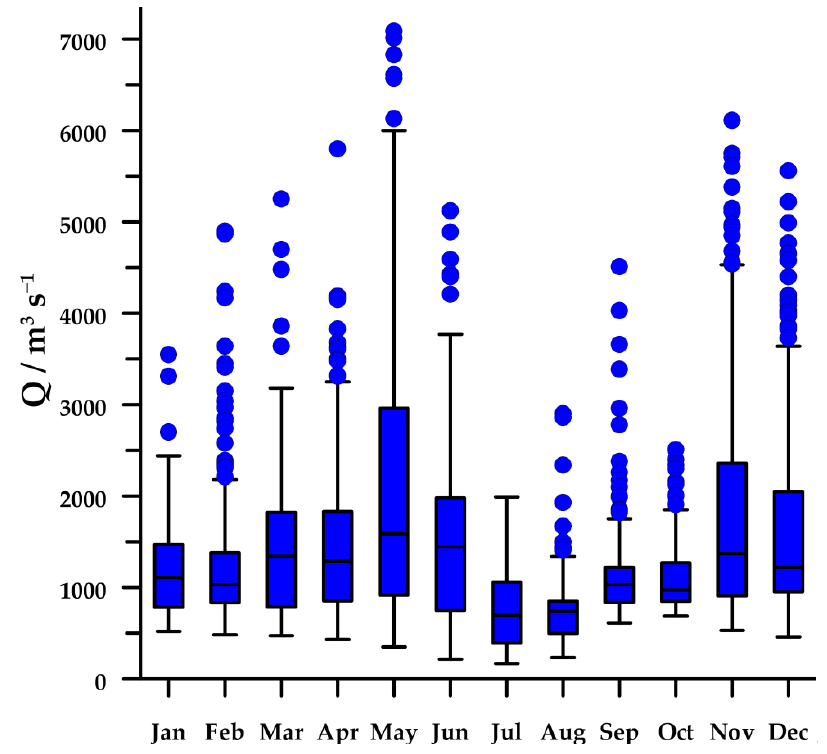
Figure 2. Annual cycle of the Po River flow during 2004–2013. In box–whisker plots are presented: median, interquartile, range of 95% of the data, and outliers (filled circles).